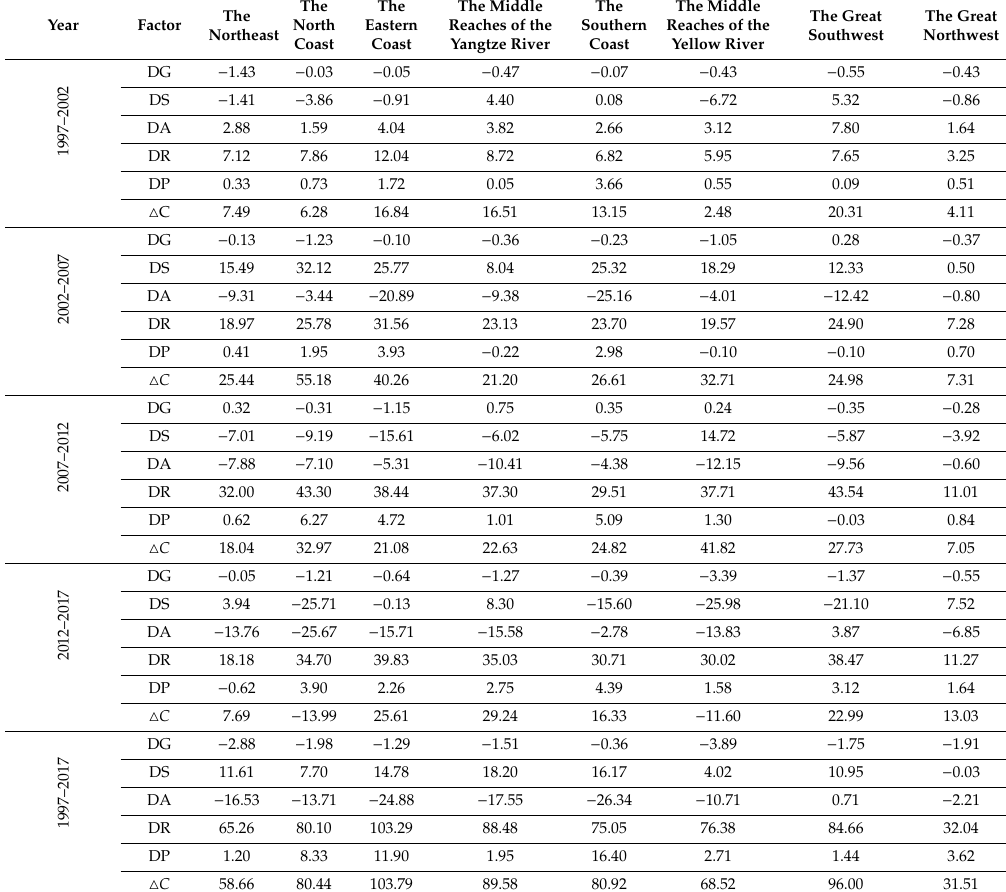
Table 4. Results of LMDI decomposition for carbon emissions from transportation industry in the 8 regions (unit: million